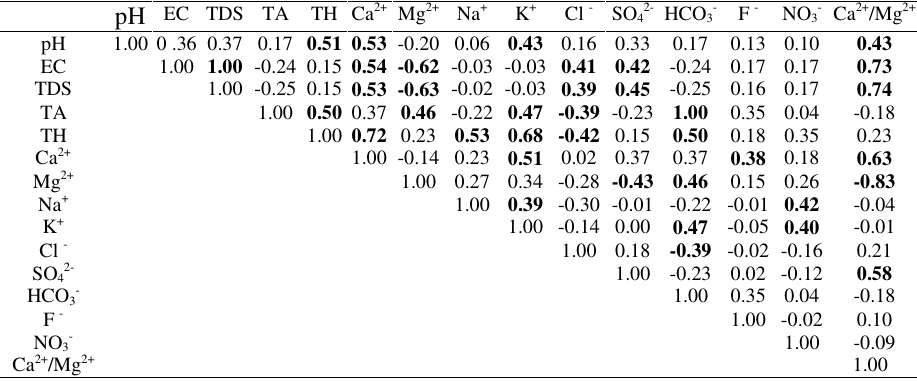
Table 3. Correlation matrix for wells water parameters of rainy